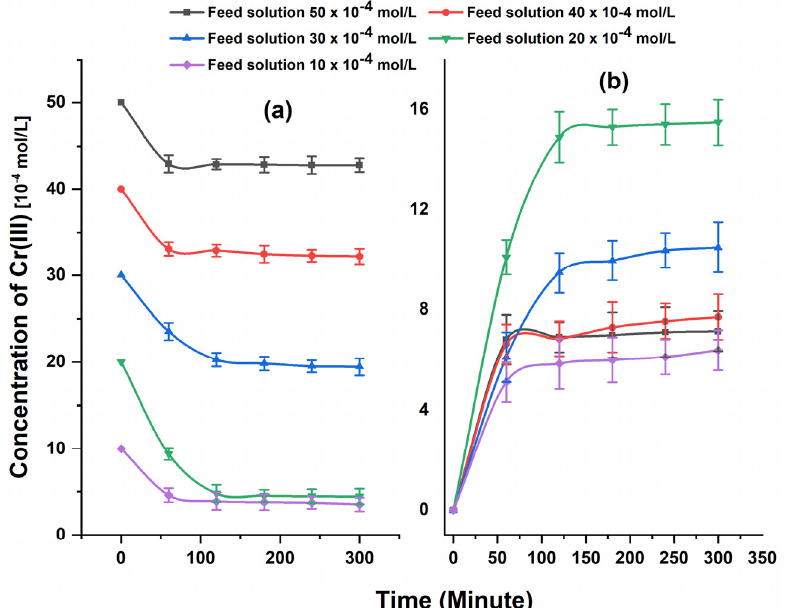
Figure 6. Concentration of Cr (III) in the feed phase ( a ) and stripping phase ( b ) at various D2EHPA concentrations; [CrIII] = 20 × 10 − 4 mol/L, [HCl] = 1.25 mol/L.